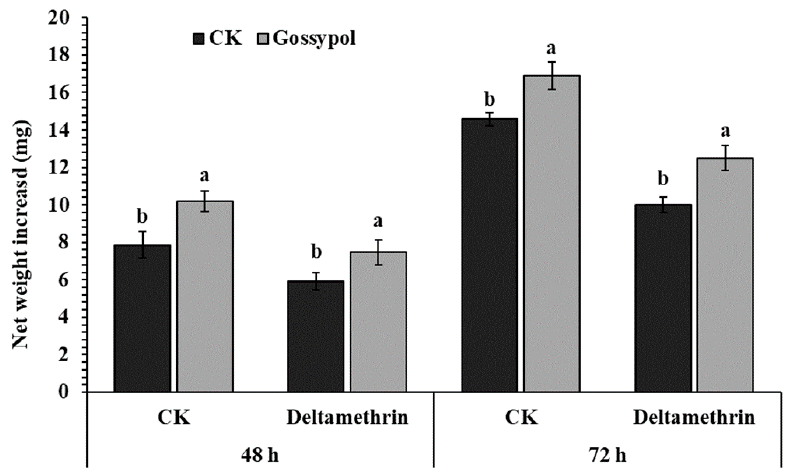
Figure 1. Net weight increase in gossypol-pretreated larvae on deltamethrin-supplemented diet. The early third instar larvae had previously fed on control (CK) or 1 mg/g gossypol-supplemented (Gossypol) diet for 1 day; after recording the initial weight, two independent groups of each treatment were transferred to 0.887/L deltamethrin-supplemented diet and control diet, respectively, weight increases were recorded 2 days later. Error bars represent standard deviation. Different letters above bars indicate significant differences ( p < 0.05) according to the Student’s t -test.